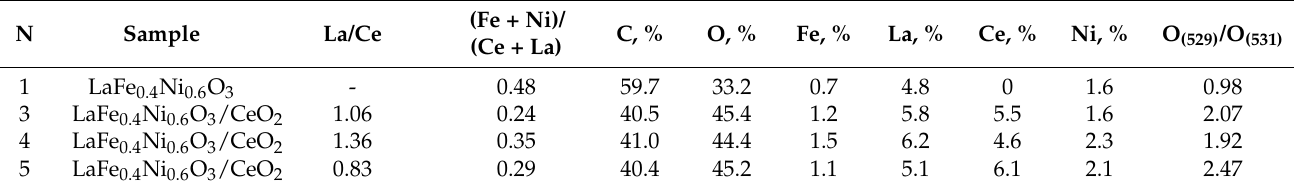
Figure 4. O1s XPS spectra for LaFe 0.4 Ni 0.6 O 3 /CeO 2 samples. Table 3. Sample surface composition (at %), ratio of atomic concentrations of elements and ratio of oxygen states according to XPS data.